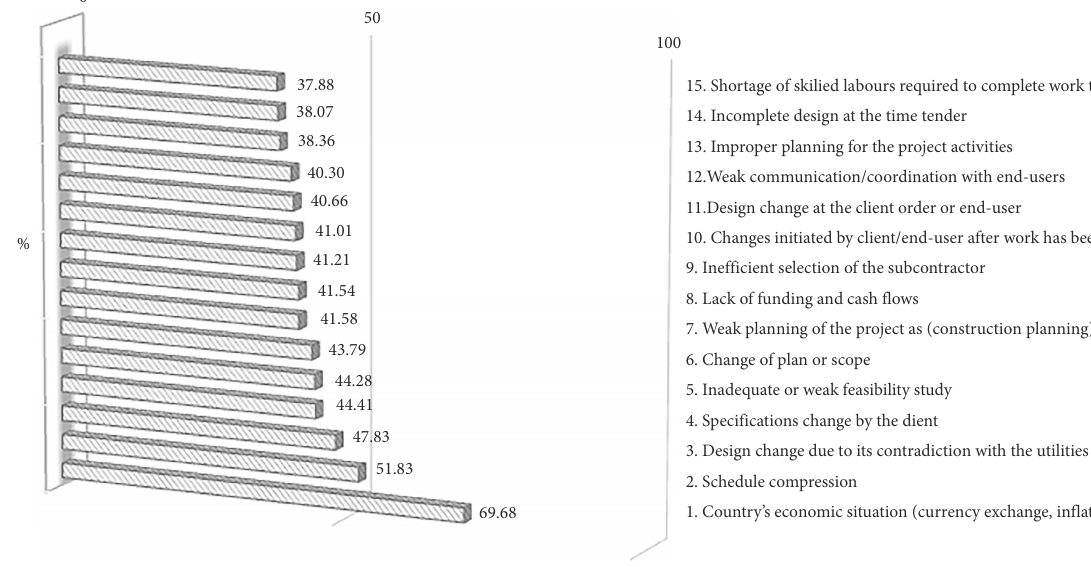
Figure 3. The most critical rework factors in